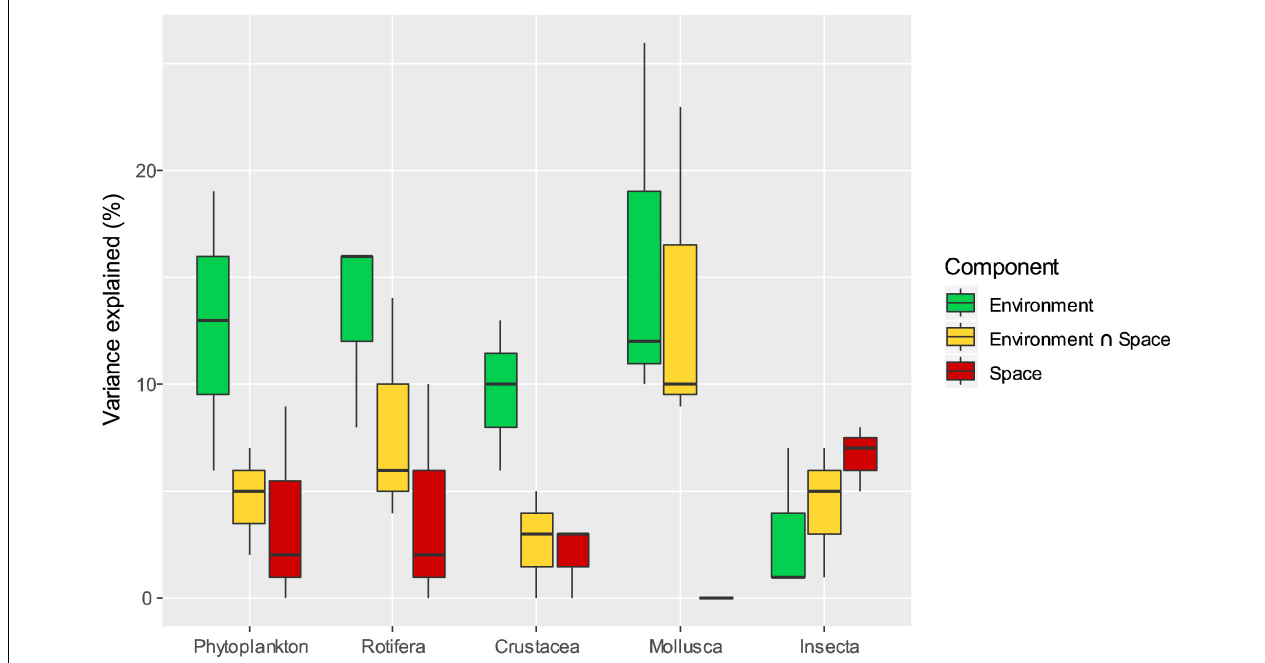
FIGURE 5 | Results of variation partitioning analyses of Phytoplankton, Rotifera, Crustacea, Mollusca, and Insecta studied for each sampling season separately. The variability among seasons is represented in a boxplot graph. The percentage of explained variation for each component is represented with a different color.